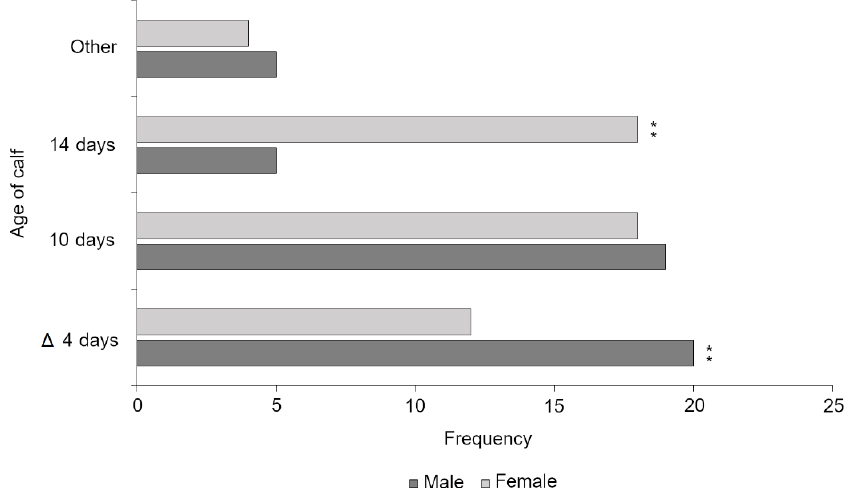
Figure 1. Veterinary opinion on the minimum age at which a young calf is fit for transport. The current legislative minimum age of fitness for transporting young calves has been denoted by a delta symbol. Significant differences between genders following Bonferroni correction (0.05/3 = 0.017) have been marked with a double asterisk ( p = 0.005). There was also a significant difference between veterinarians working with different species ( p = 0.001). Veterinarians working in large animal practice ( n = 39) supported a lower age of fitness for transport (μ = 7.26 days, σ = 4.02) than veterinarians working in companion animal practice ( n = 21, μ = 11.71 days, σ = 3.18) and mixed animal practice ( n = 35, μ = 9.54 days, σ = 5.19). Post hoc pairwise comparisons with Bonferroni correction (0.05/9 = 0.006) found that veterinarians working in large animal practice were significantly more likely to select a 4 or 10 day minimum age of fitness for transport than veterinarians working with companion animals, who were more likely to select a 14 day minimum age ( p = 0.001 and p = 0.005, respectively; Figure 2). The number of years since graduation was not found to be significant ( p = 0.998).